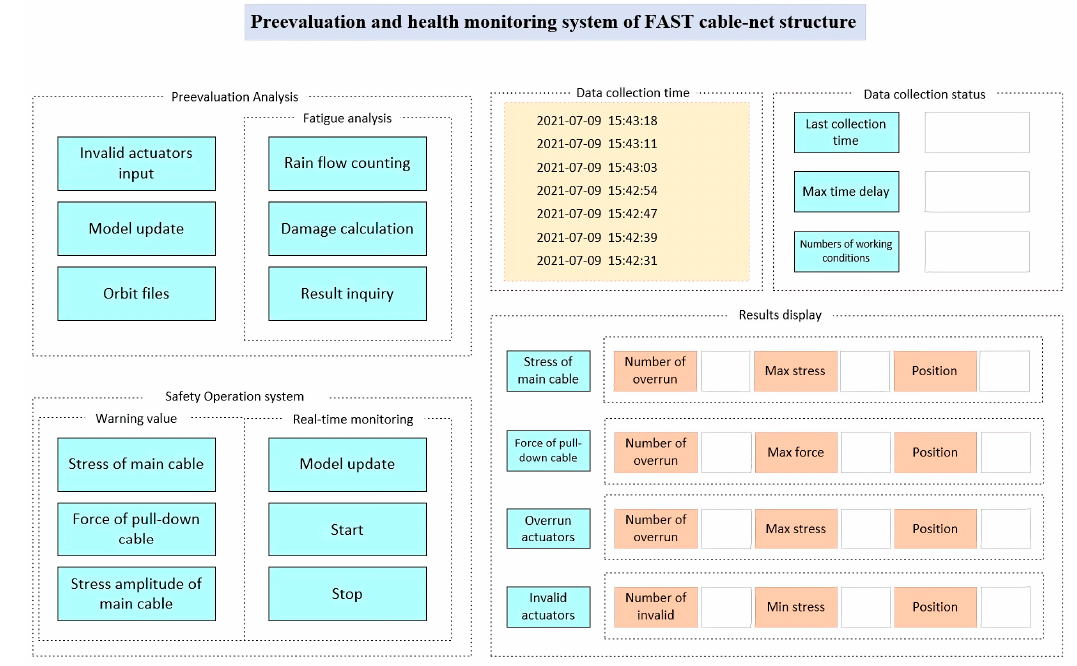
Figure 8. Schematic diagram of PHM